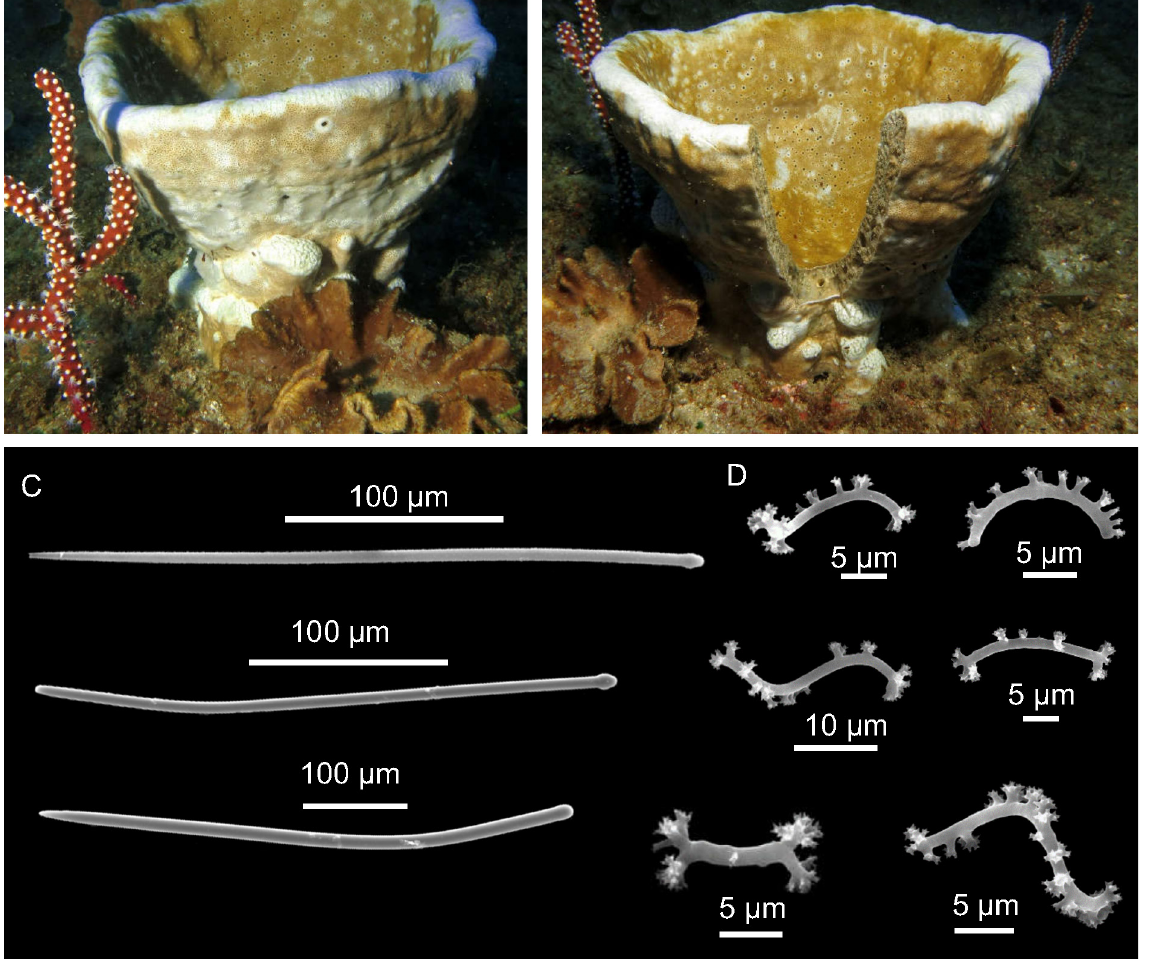
Fig. 16. Spheciospongia ndabazithe Samaai et al ., 2019. A . Specimen PO52 in situ . B . The cut highlights the compact, darker choanosome. C . Tylostyles in different shapes. D . Spirasters variable in